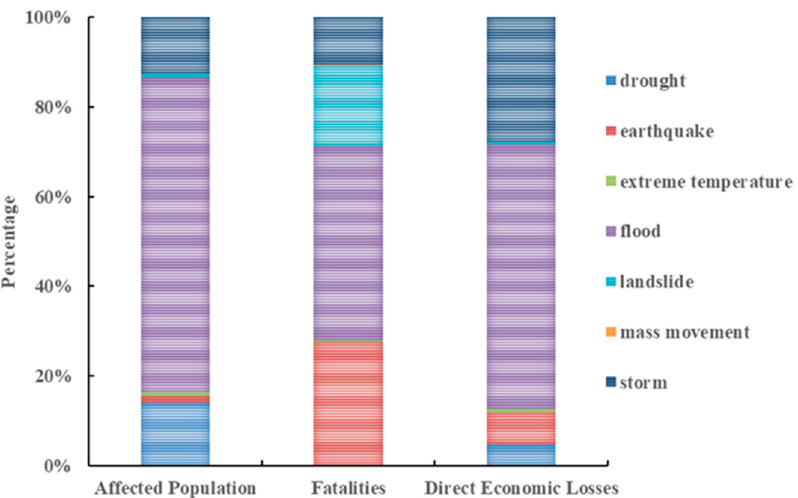
Figure 4. Annual average percentage losses (affected population, fatalities and direct economic losses) caused by drought, earthquake, extreme temperature, flood, landslide, mass movement and storm, as proportions of the total losses during 2010–2020.